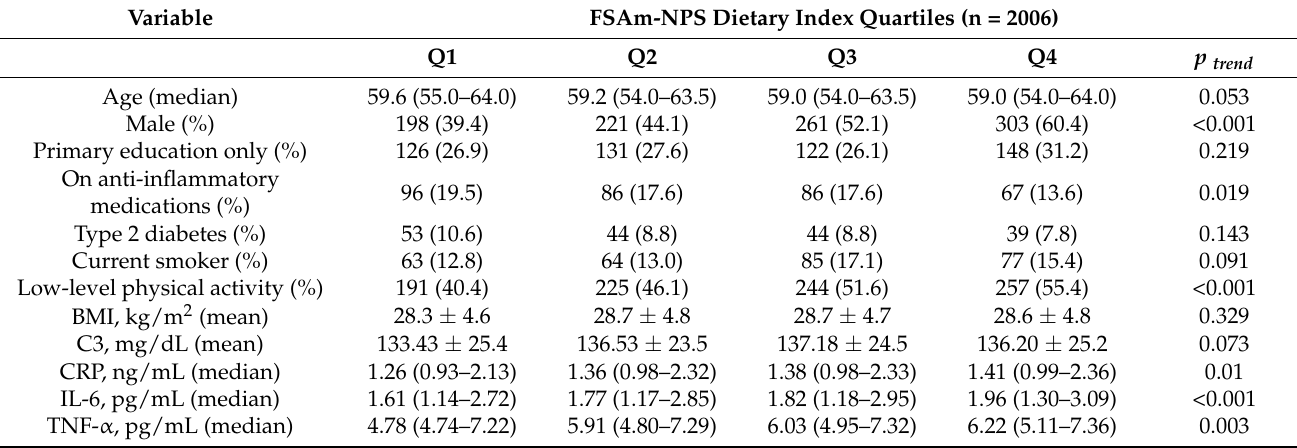
Table 1. Descriptive characteristics and inflammatory profiles of the study population according to FSAm-NPS dietary index